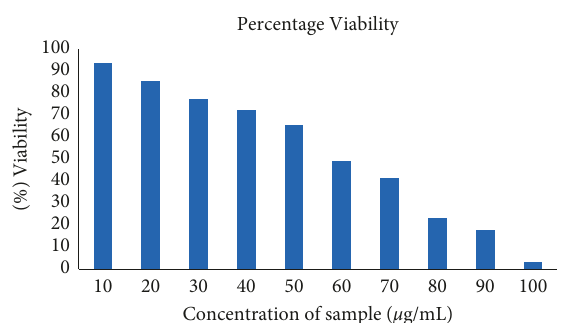
Figure 8: Cell viability measured with trypan blue exclusion assay. 10–100 μ g/mL concentration of SP-ZnONPs was treated with A549cell